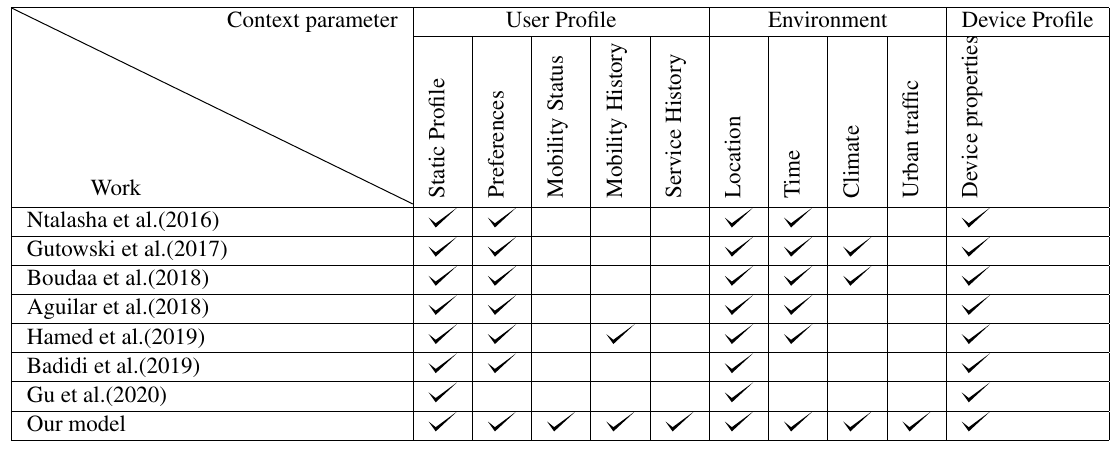
Table 1. comparison between different